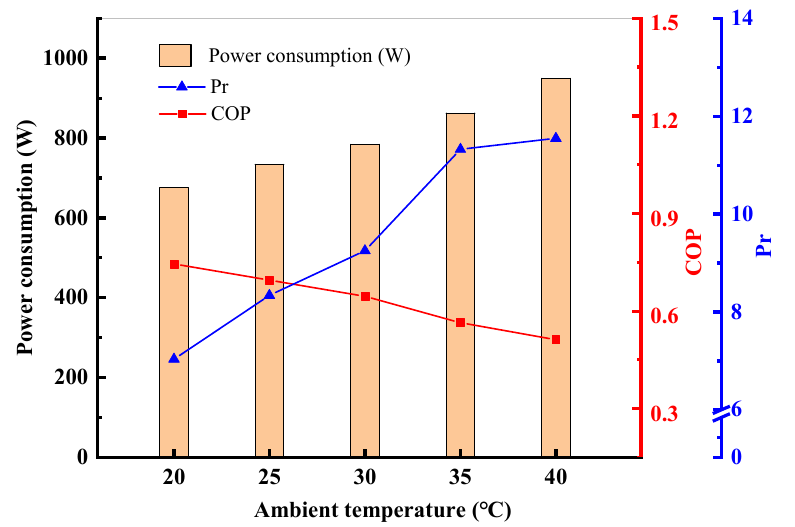
Figure 7. The compressor power consumption, coefficient of performance, and ratio of pressure change at different ambient temperatures.